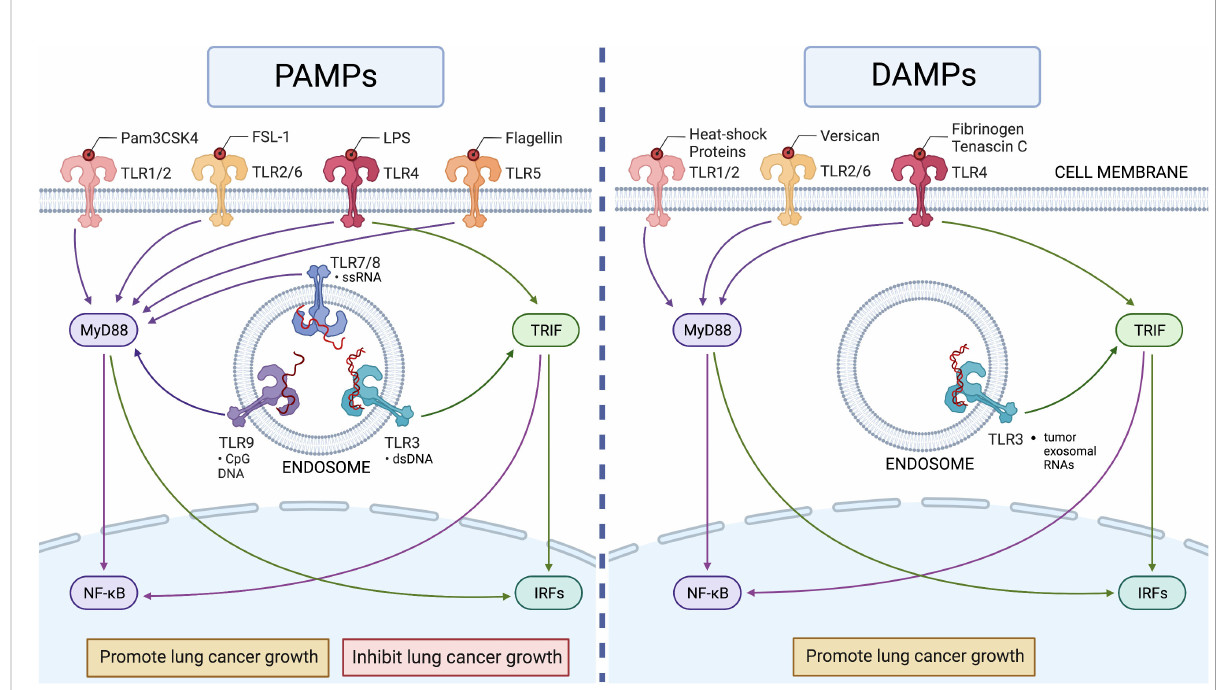
FIGURE 1 The roles of TLRs in lung cancer. Left panel: Human TLR1 to TLR9 recognize their ligands in pathogens (PAMPs) to activate MyD88-dependent (for all TLRs except TLR3) and TRIF-dependent (only for TLR3 and TLR4) pathways to induce innate immune responses in lung cancer. The activation of TLRs can show both pro- and anti-tumor activities depending on the setting. Right panel: Human TLR2 to TLR4 recognize endogenous ligands (DAMPs) in lung cancer, but these recognitions appear to induce only pro-cancer activity (Table 1). This fi gure was generated using